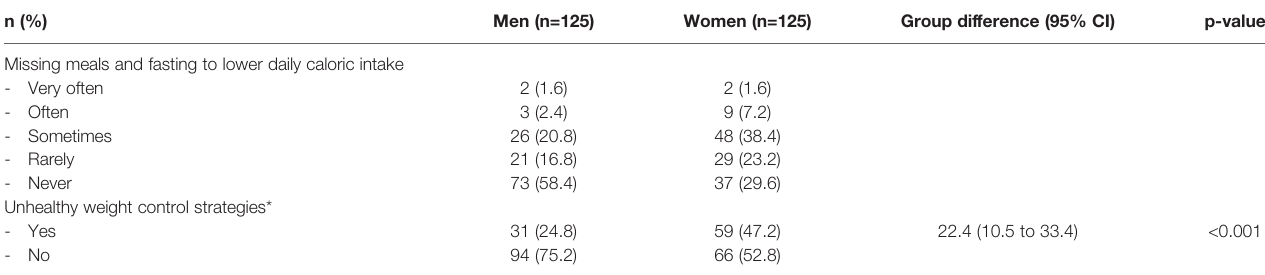
TABLE 3 | Energy-restricted dieting and prevalence using unhealthy weight control strategies (missing meals and fasting) to lower daily caloric intake by sex (n=250).